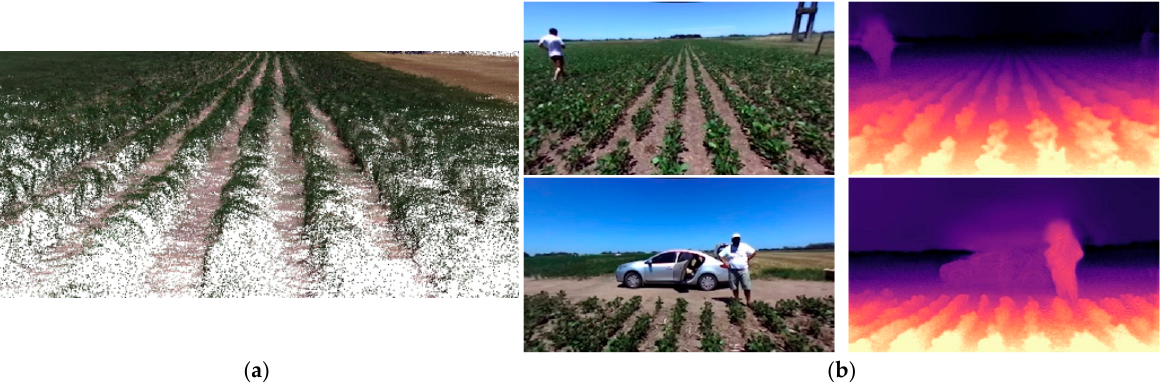
Figure 9. ( a ) Geo-referenced map (dense point cloud) of soybean field reconstructed from dataset Rosario [26] using SLAM and MVS; ( b ) scene geometric estimation (depth map) from an unsupervised CNN, which can be used to simulate RGB-D SLAM and boost real-time dense reconstruction [27].